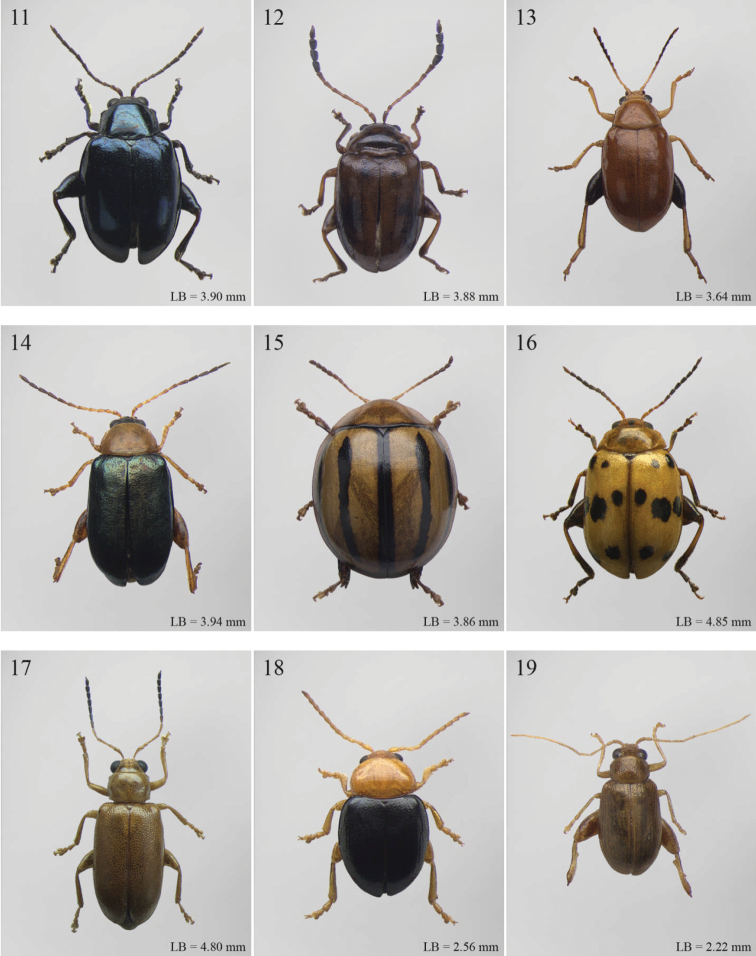
Habitus .11
Angulaphthona heteromorpha (Bechyné) 12
Antanemora ghesquierei (Bechyné) 13
Aphthona senegalensis Jacoby 14
Aphthona (ex Ethiopia Scherer) tricolor (Scherer) 15
Argopistes sexvittatus Bryant 16
Argopistoides africanus (Bryant) 17
Bangalaltica antennalis Bechyné 18. Bechuana nigripes Scherer 19
Bechynella pallens (Bechyné).